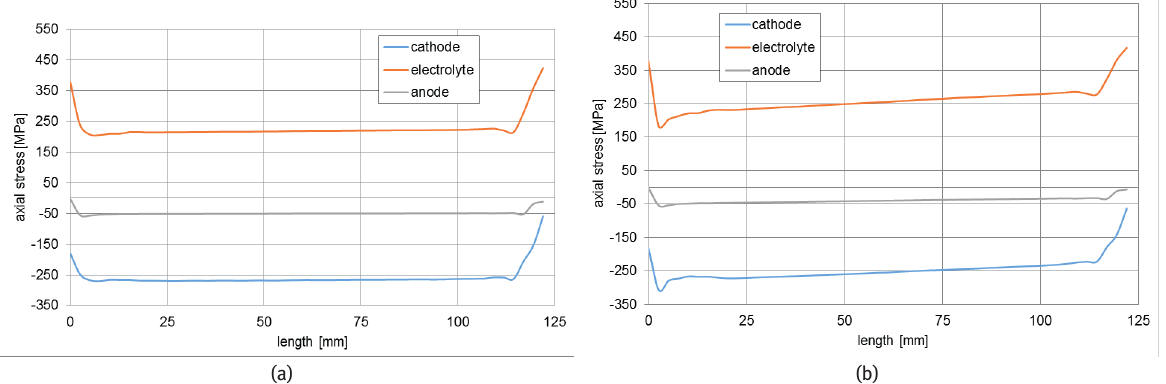
Figure 14: Distribution of operating axial stress of the mSOFC stack with supporting structure along the horizontal centerlines of each layer: (a) cross-section I, (b) cross-section